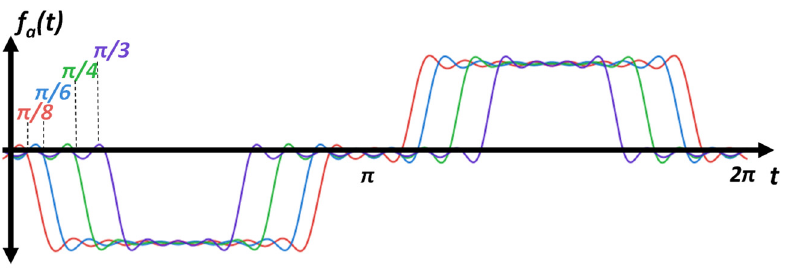
Figure 10. Effect of increasing firing angle in a 3-level inverter.